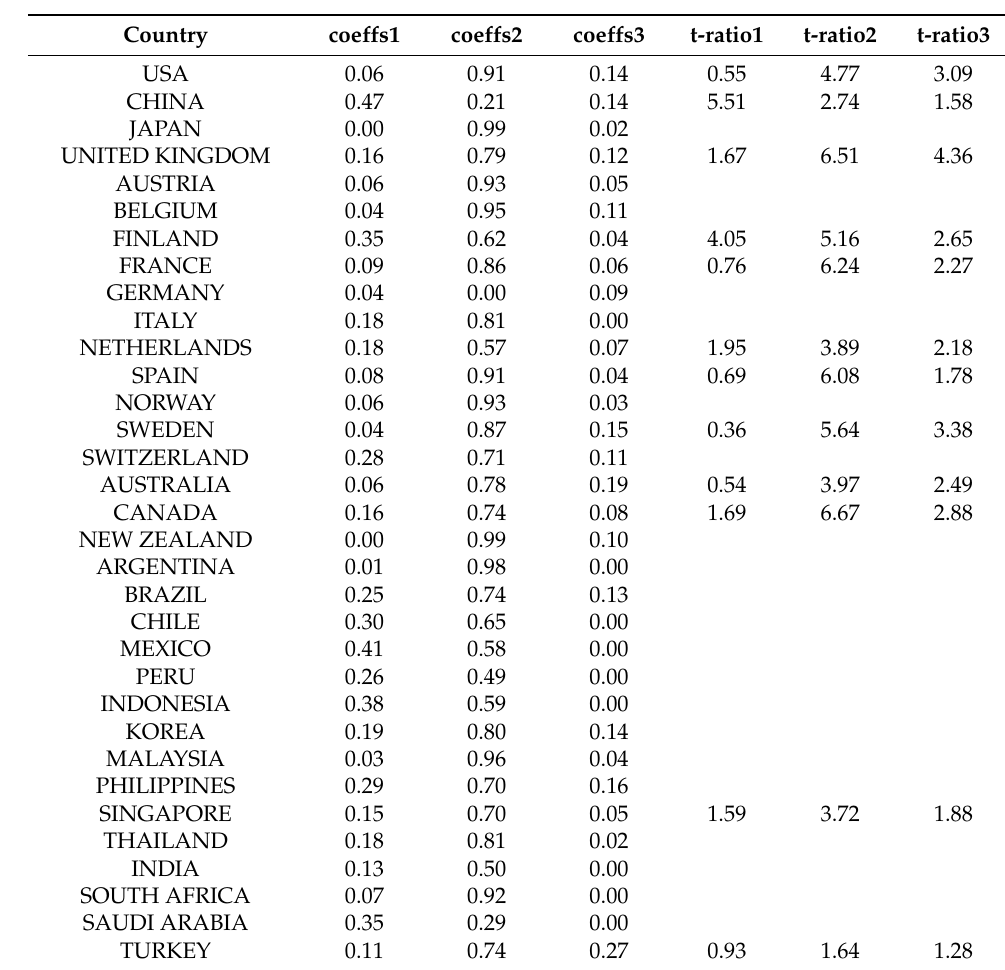
Table A8. Phillips